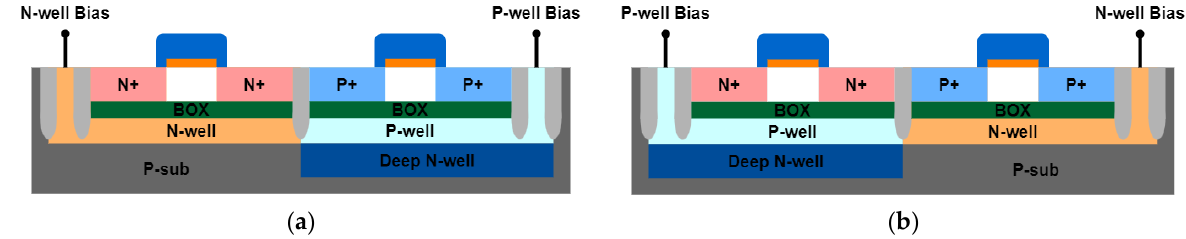
Figure 4. ( a ) Flipped well configuration (FBB); ( b ) regular well configuration (RBB).